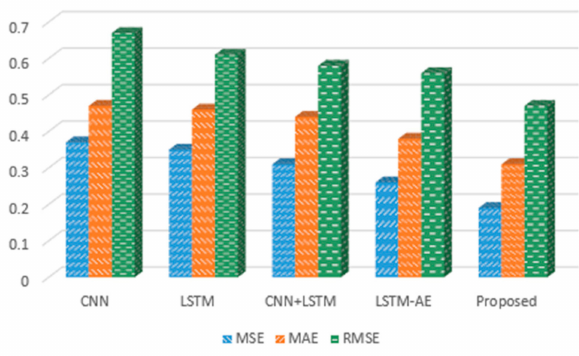
Figure 8. The MSE, MAE and RMSE error rates of di ff erent deep learning models for hourly electricity prediction.